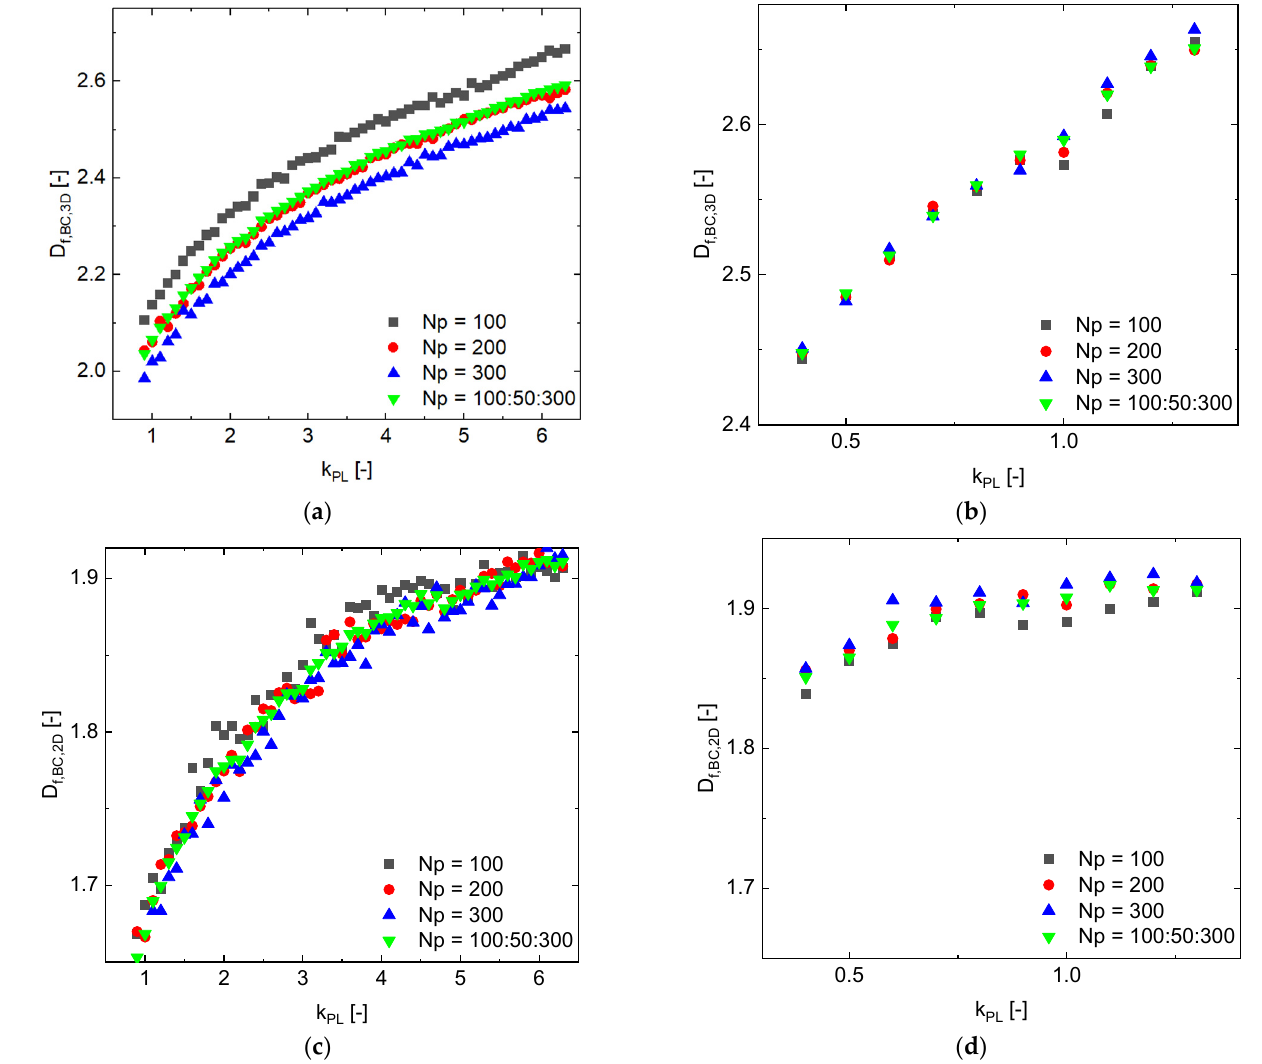
Figure 6. Relationship between D f , BC ,3 D and D f , BC ,2 D with k PL : ( a ) D f , PL = 1.8 and BC in 3D,